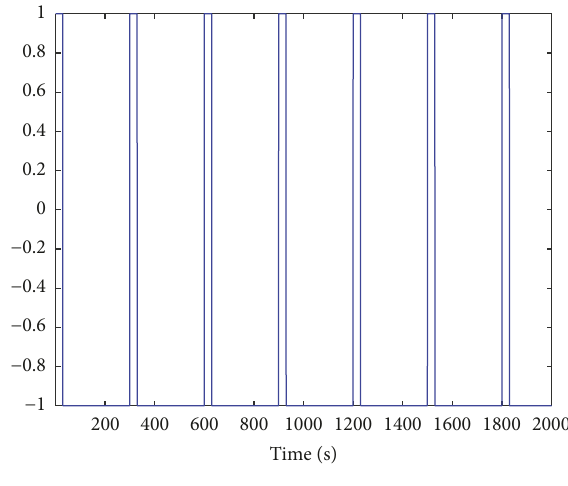
Figure 6: Switching signal.